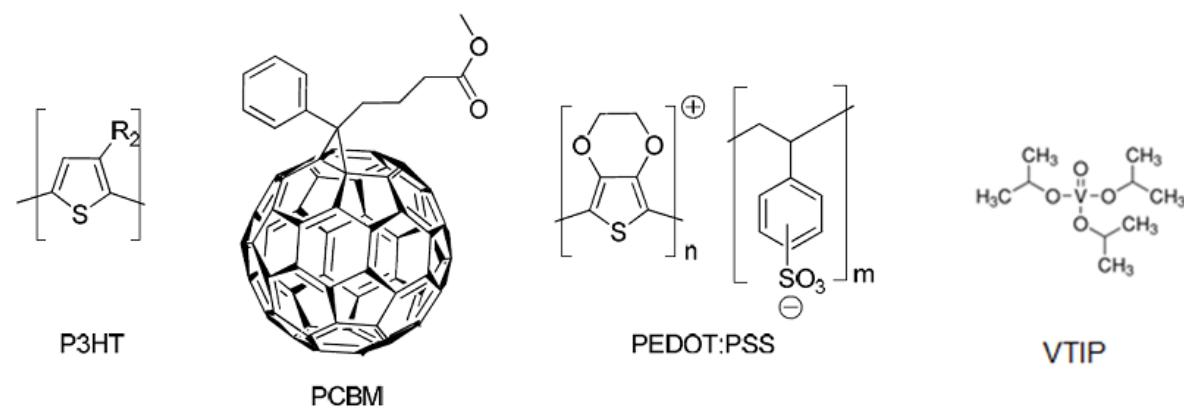
Figure 2. Chemical structures of materials employed in this study: P3HT, PCBM, PEDOT:PSS, and VTIP, R2 =